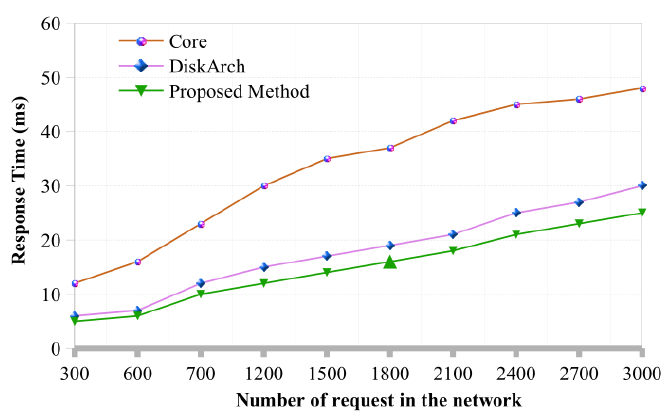
Figure 7. Overall response time of Blockchain enable SDN-IoT architecture.